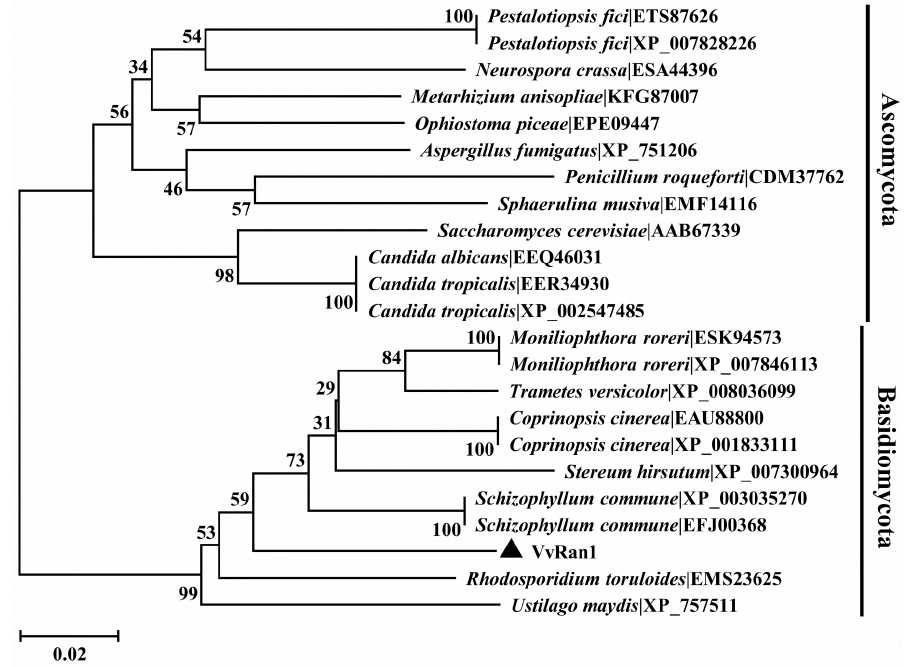
Figure 4. Phylogenetic analysis of V. volvacea and other fungal Ran sequences. All sequences except VvRan1 were downloaded from the NCBI database. The clades were named by the Latin species names, followed by the NCBI accession number. The Ran GTPase of V. volvacea was labeled by black triangle. The confidence levels of the nodes were tested by bootstrapping 1000 times.